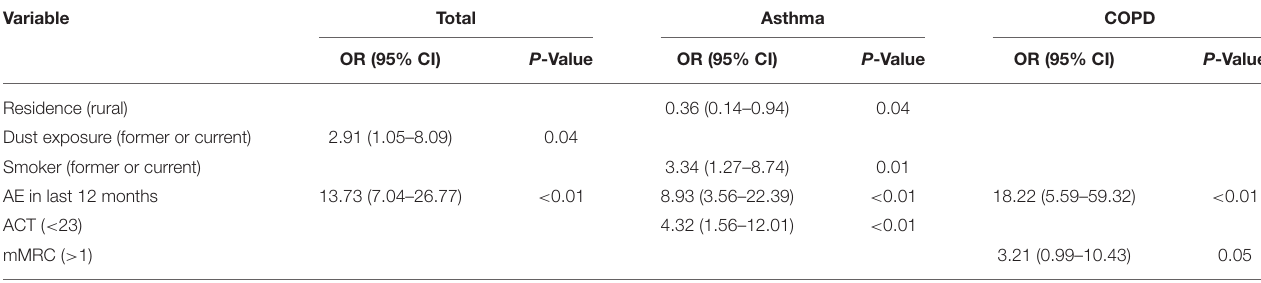
TABLE 5 | Logistic regression analysis of risk factors related to AE.